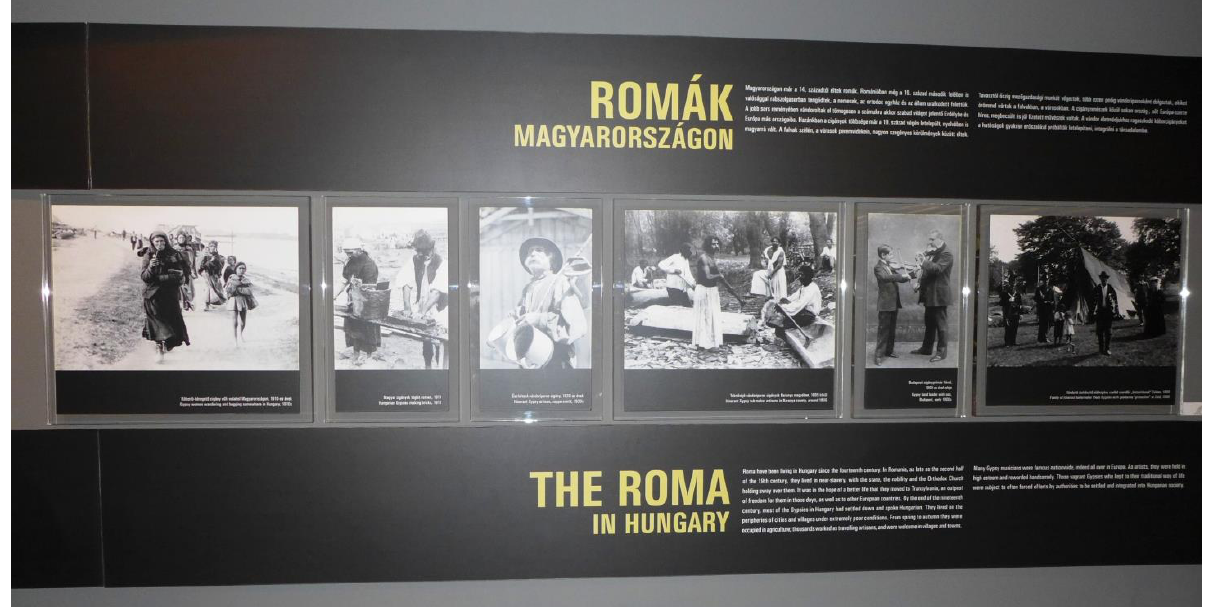
Figure 4. The Roma section in the introductory room of the Holocaust Memorial Center in